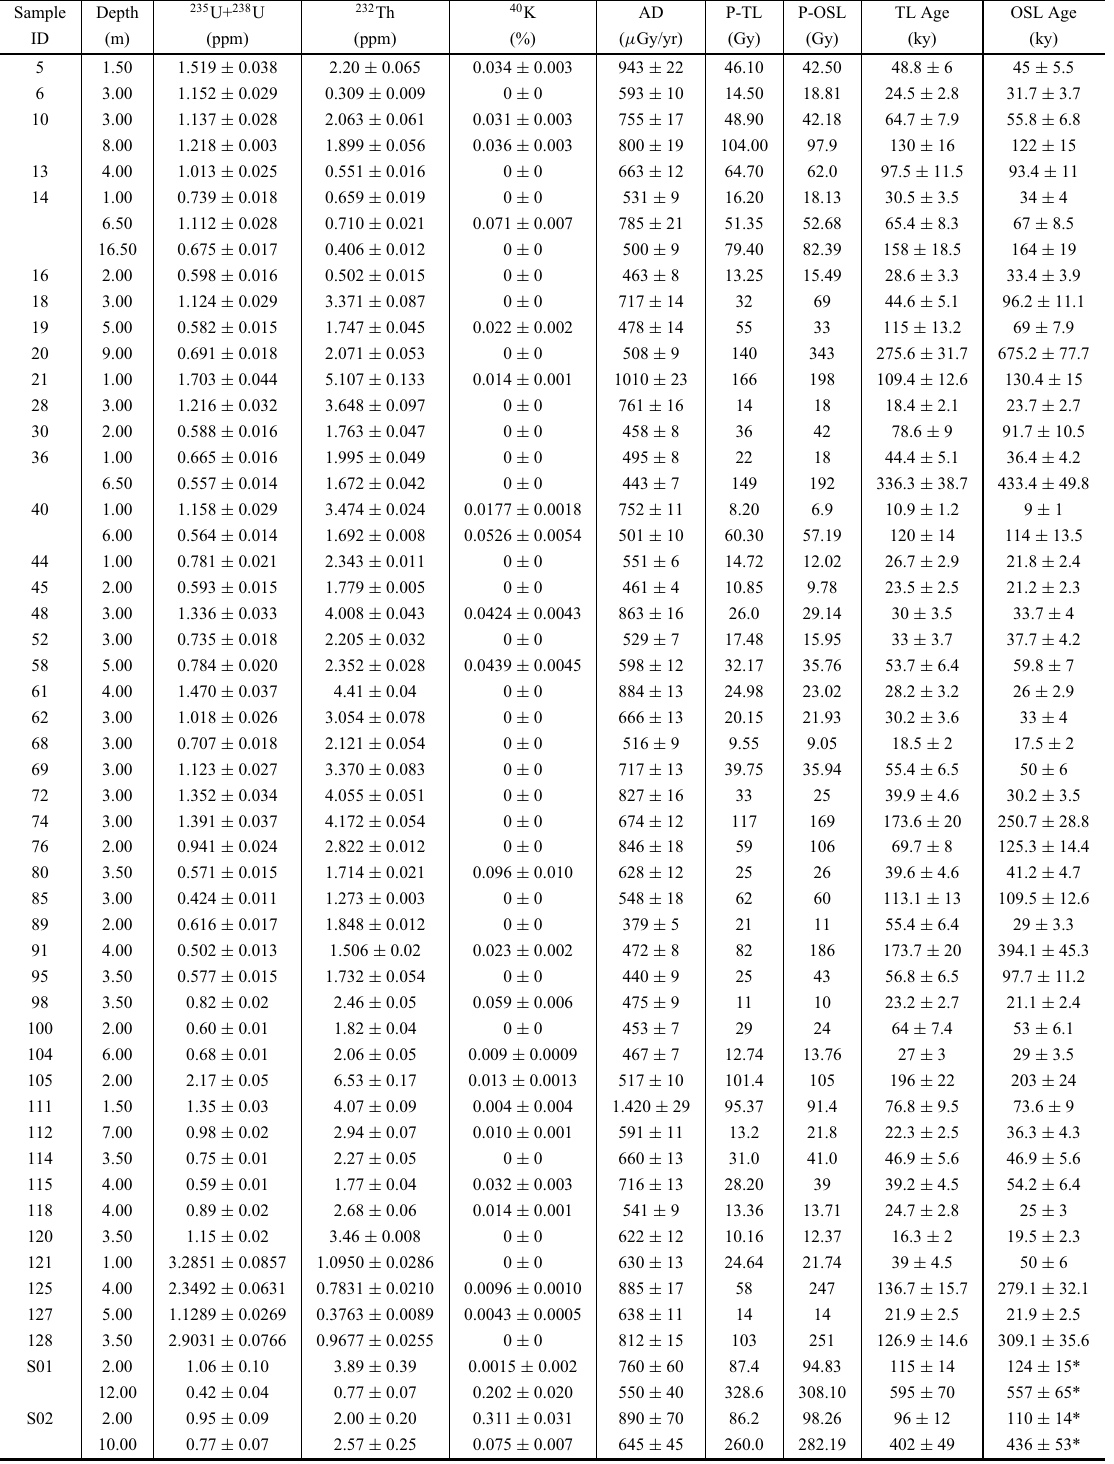
Sample numbers, natural radioactivity, paleodoses (P), annual doses (AD), and ages by luminescence for samples from colluvial deposits. Green and blue stimulation were used for OSL measurements. (*OSL SAR).